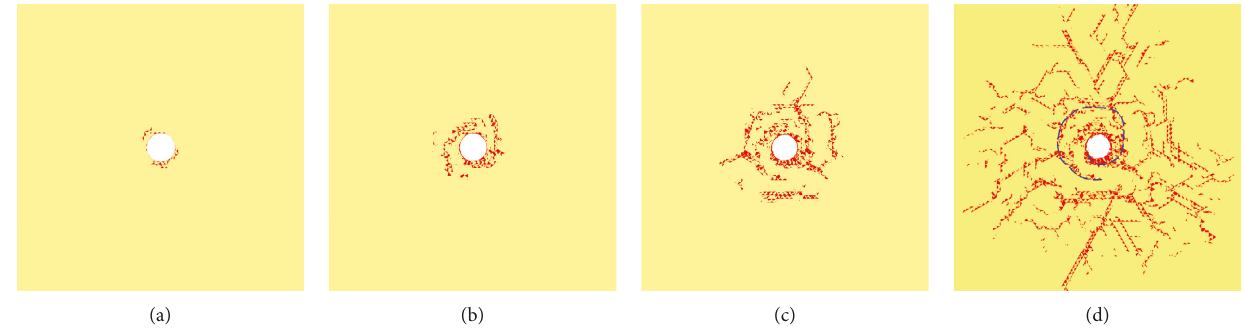
Figure 8: Fracture distribution around the roadway boundary at different time step. (a) 5000 steps. (b) 10000 steps. (c) 18000 steps. (d) 34000